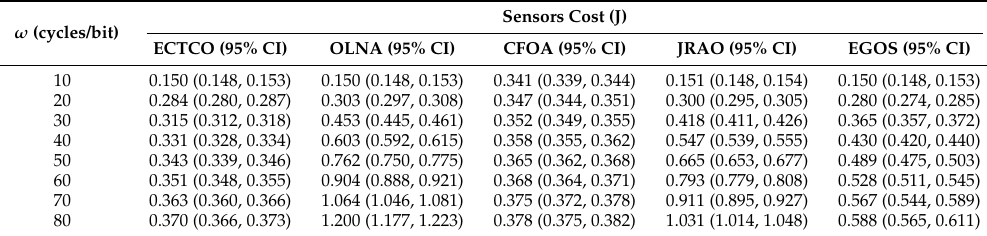
Figure 5. Impact of different parameters. Table 4. Sensors cost versus ω